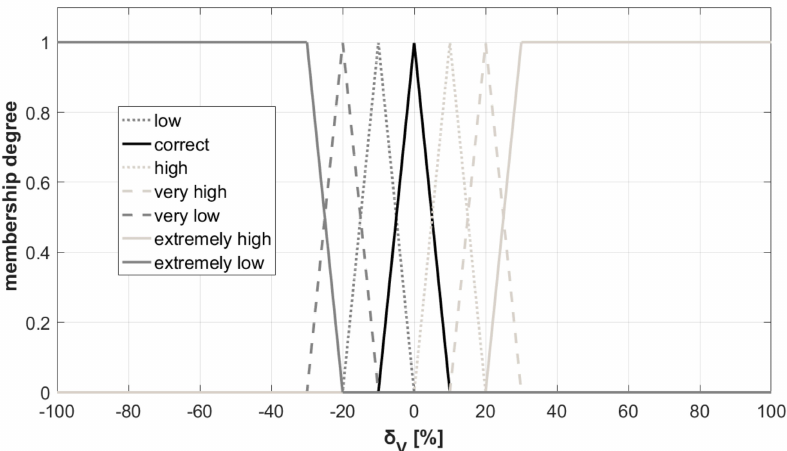
Figure 8. Membership degree of the input variable δ V vertical deviation (control error in this case) of the yellow circle from the center of the picture, associated with fuzzy sets: extremely low, very low, low, correct, high, very high, extremely high. To be maintained as correct is to be led to zero.